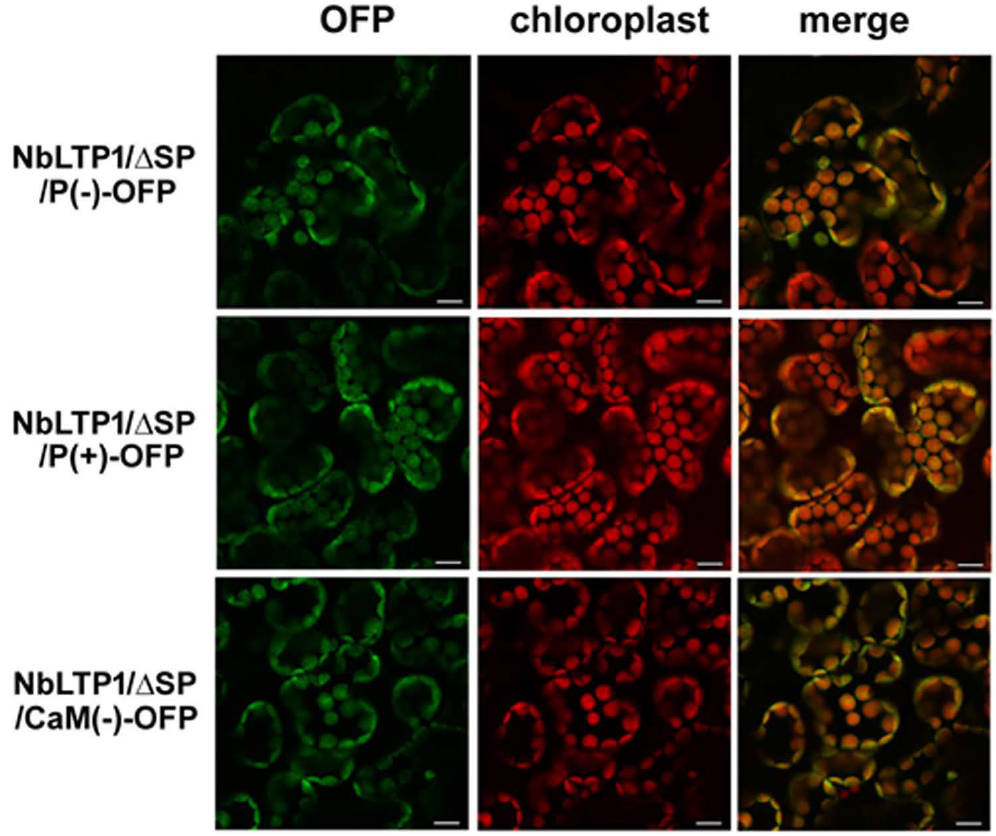
Figure 5. Subcellular localization of NbLTP1 / ∆ SP-OFP mutants in N. benthamiana . OFP-fused NbLTP1 / ∆ SP mutants were transiently expressed by agroinfiltration in N. benthamiana leaves. Images were obtained under an Olympus Fluoview FV1000 confocal microscope with 543 nm and 633 nm laser excitation. OFP is shown in green, and the autofluorescence of chloroplasts is in red. Scale bar is 10 μm.